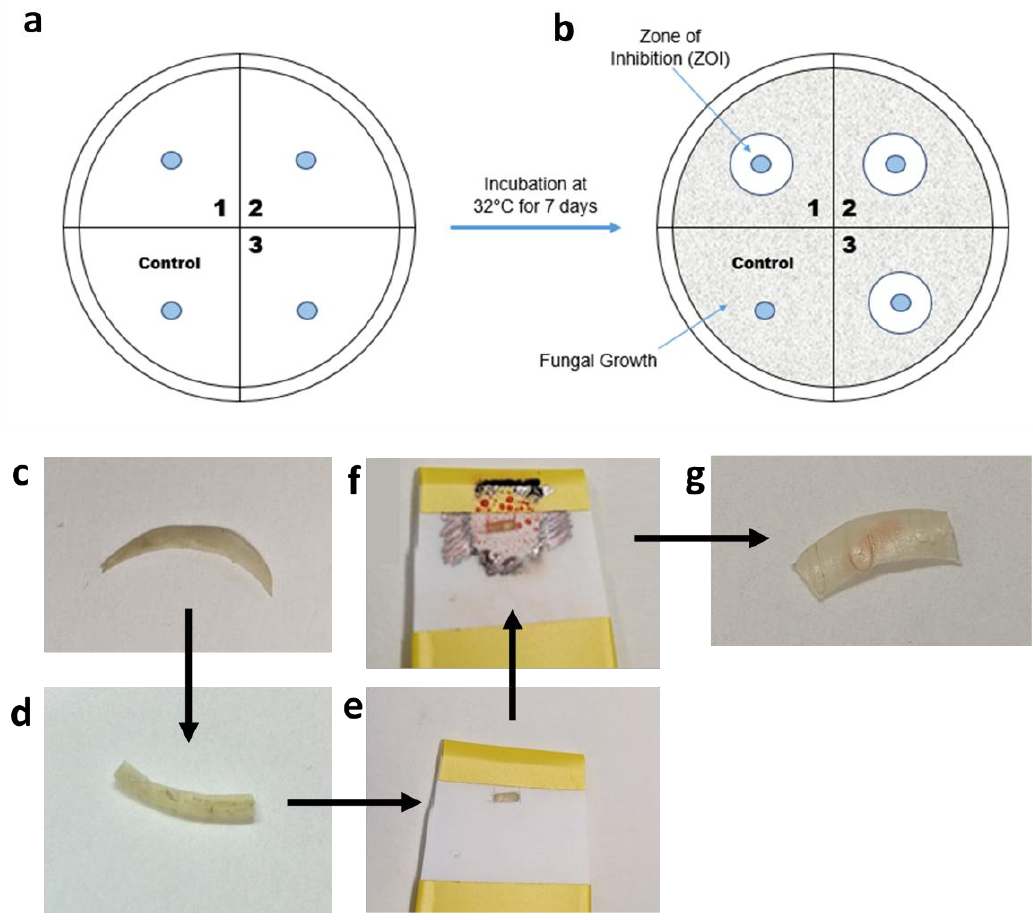
Figure 2. ( a , b ) Diagrams of the disc diffusion assay procedure. ( c – g ) Pictures of the steps taken in nail printing. ( c ) The initial nail is chosen, and is cut in half ( d ) and then loaded into the nail holder ( e ). ( f ) The nail holder is printed onto and, once dried, the nail can be removed from the printer ( g ).